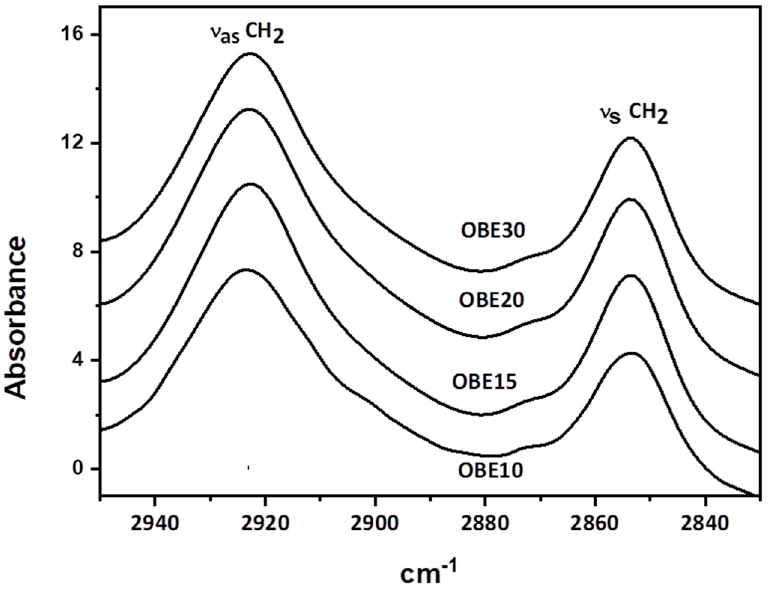
Figure 2. ATR-FTIR spectra in the 2950–2830 cm − 1 region of oat bran O/W emulsion. See Table 1 for sample description